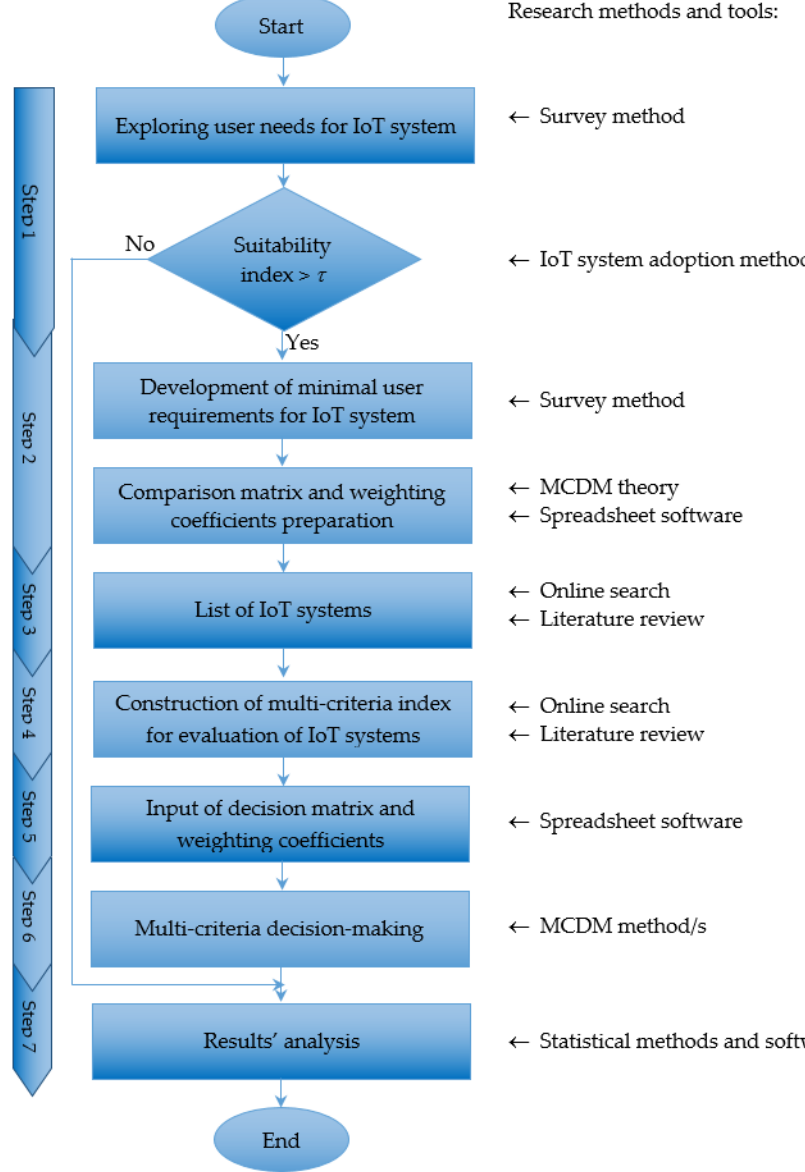
Figure 2. A flowchart of the proposed framework for IoT system selection.